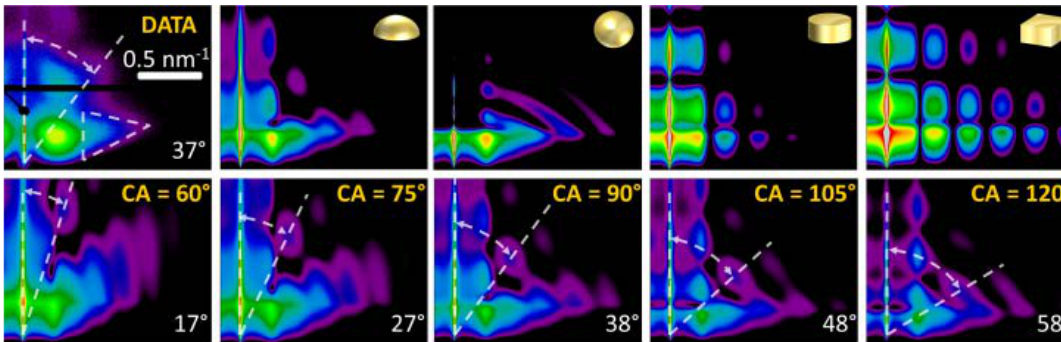
Figure 5. Sputter deposition of Au on amorphous silicon oxide. The upper rows shows the grazing incidence small-angle X-ray scattering (GISAXS) data at δ Au = 6.3 nm (upper left pattern), compared with model-based simulations of expected GISAXS pattern for different cluster geometries (upper row). The geometry of the cluster is depicted in the upper right corner of each pattern. The form factor of the clusters leads to characteristic shapes of the out-of-plane peaks (in horizontal direction) and leads to changes in the intensity and sharpness of height modulations (vertical direction). The curvature of the 2D intensity distribution in the region of the white triangle is indicative of the spheroidal geometry. The lower row depicts the expected GISAXS pattern, obtained by simulations, of spherical clusters with different cluster-to-substrate angle ( CA ), i.e. truncated spheres (lower row). A hemisphere corresponds to CA = 90°, which perfectly matches the data. The white number denotes angle between scattering plane and second order height maxima (dashed white lines). Adapted from reference [133] with permission from the Royal Society of Chemistry.